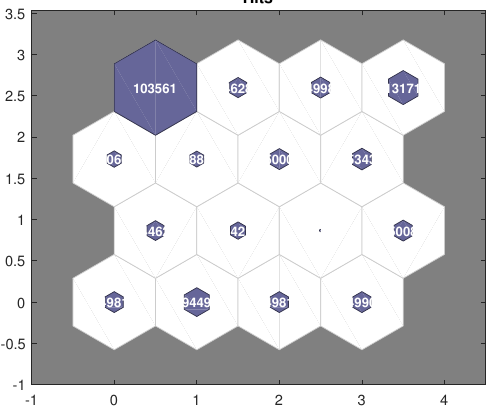
Figure 11. Self Organizing Map (SOM) sample hits. Table 4. SOM